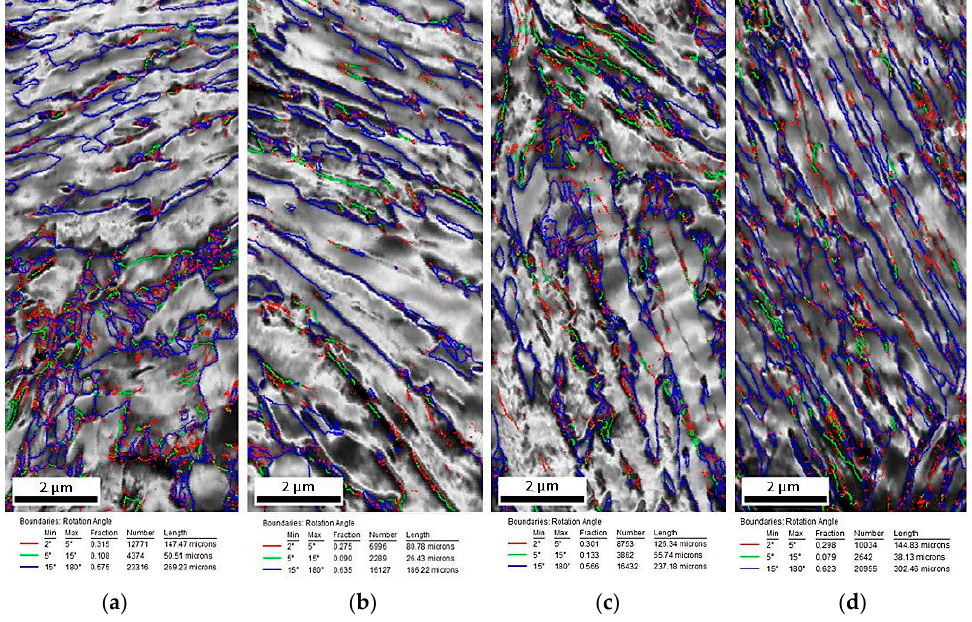
Figure 7. Image quality (IQ) maps of the steel deformed at: 20 °C ( a ), 60 °C ( b ), 100 °C ( c ), and 200 °C ( d ).